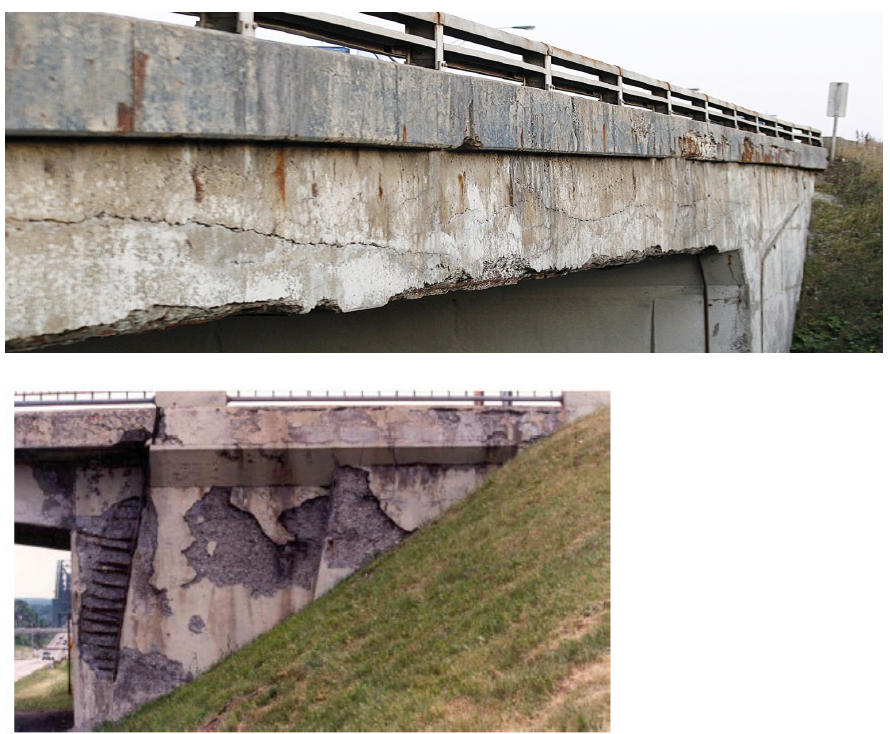
Figure 1. Typical damage caused by de-ice salts on exposed concrete bridges.